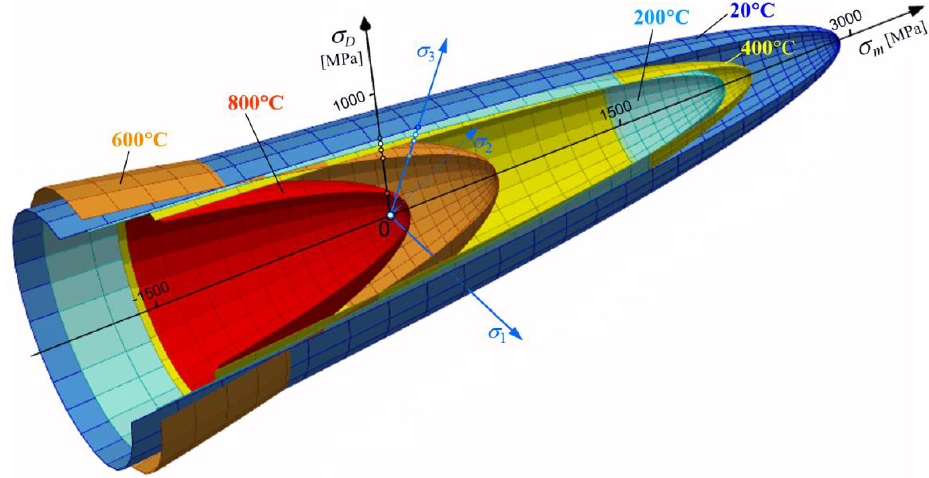
Figure 5. St12T plastic region paraboloid distribution, created using the Burzyński approach [30].